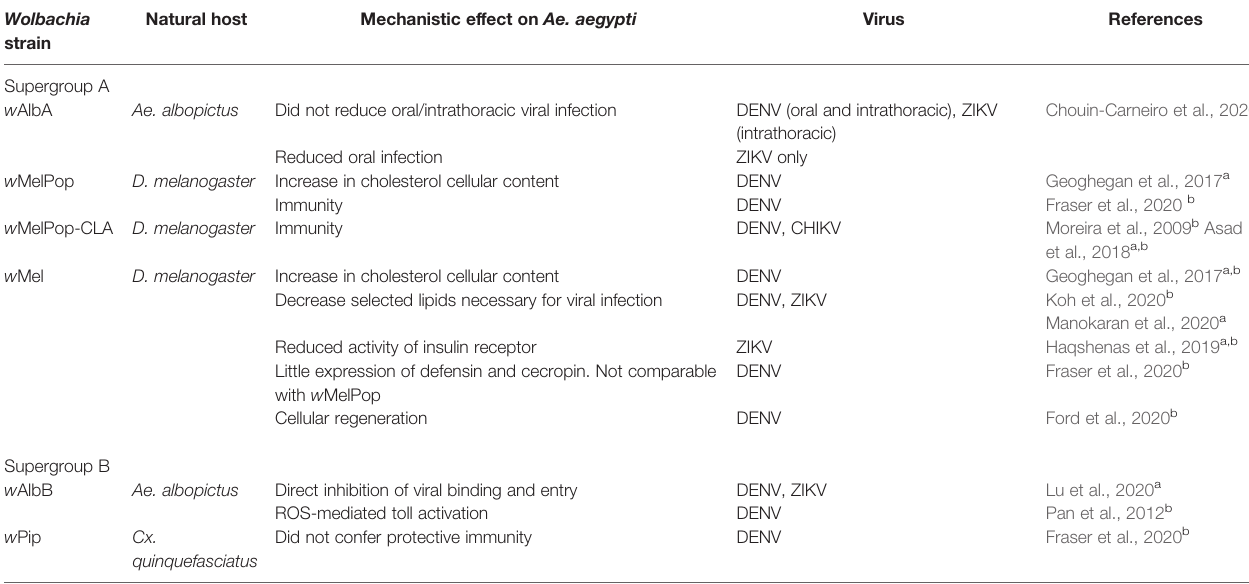
TABLE 1 | Mechanistic effects of multiple Wolbachia strains in arbovirus-infected Ae. aegypti